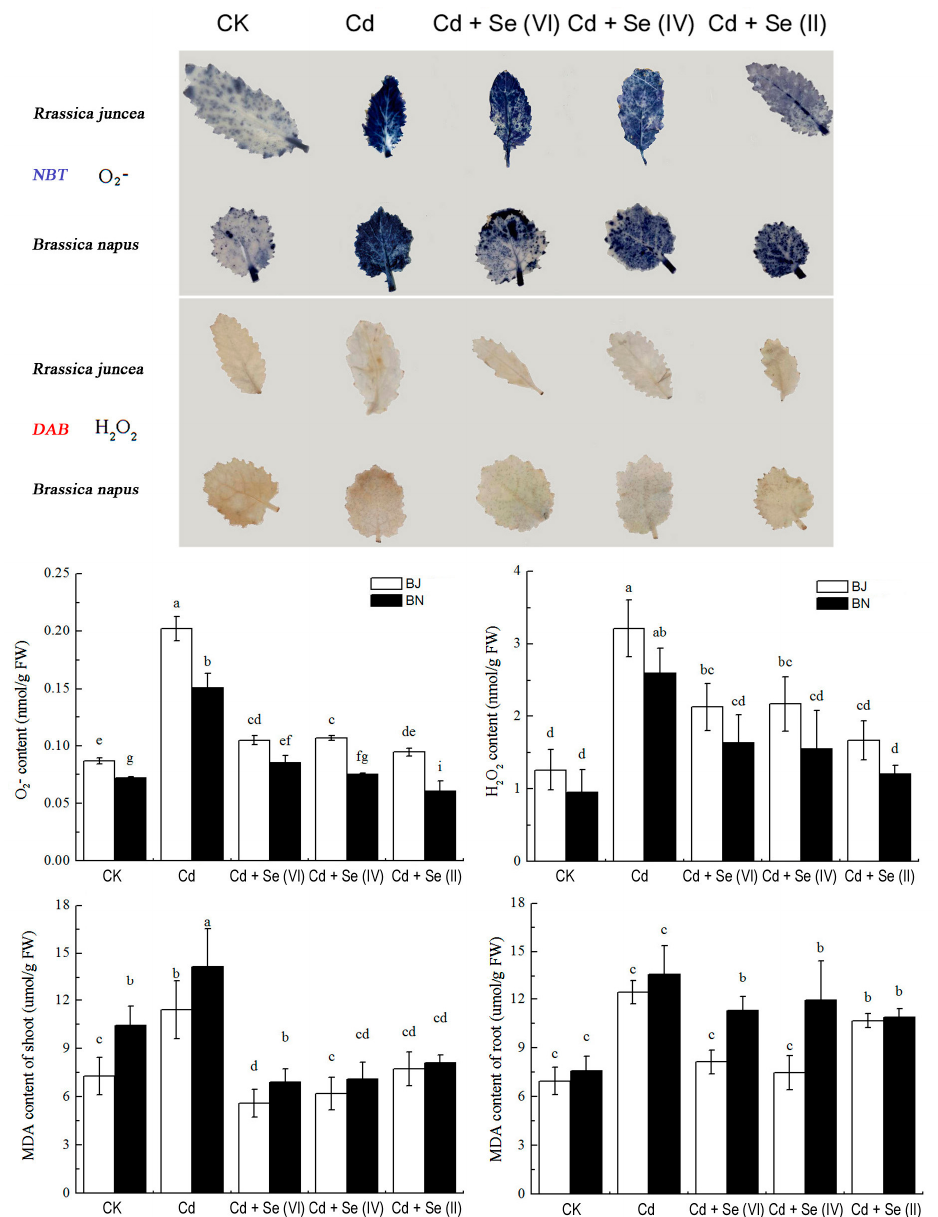
Figure 3. H 2 O 2 and O 2 − staining in shoot and root after Cd and Se experiment. H 2 O 2 , O 2 − , and malondialdehyde (MDA) accumulation in Brassica seedlings. FW: fresh weight. All values were means ± SD ( n = 3). Different small letters indicate significant difference at P < 0.05.